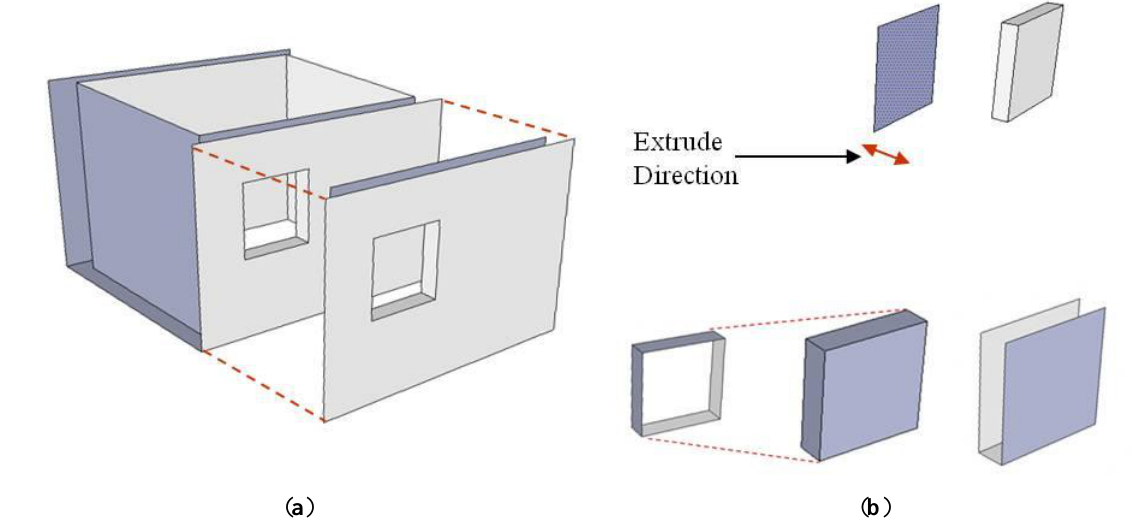
Figure 8. ( a ) A surface in CityGML with a window opening in its wall. ( b ) Extruding